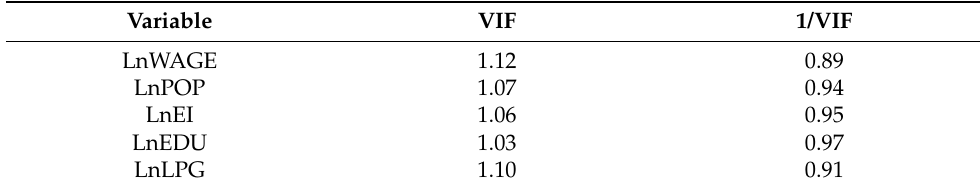
Table 3. Results of the VIF